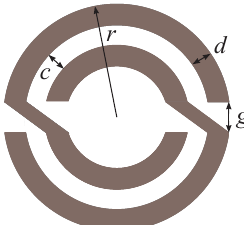
Figure 9: Geometry of the simulated NB-SRR, with r = 3.7 mm, c = 0.5 mm, d = 0.5 mm, and g = 0.5 mm. The periods of the lattice, as depicted in Figs 2 and 3, are a = b = 15 mm, and the distance from the reference planes is l = ± 3 a .